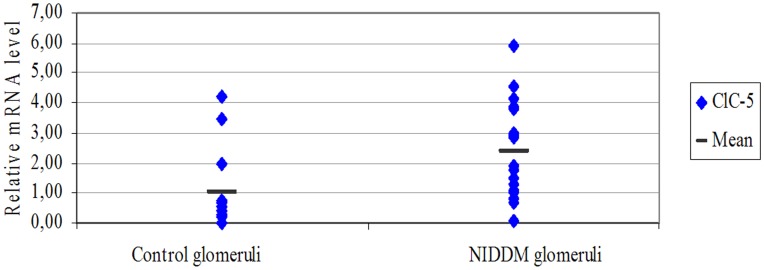
Real-Time quantification of ClC-5 in laser-microdissected biopsies of NIDDM and controls.mRNA level of ClC-5 in laser-microdissected glomeruli from NIDDM cases and controls. ClC-5 mRNA levels were significantly higher in NIDDM glomeruli than in control glomeruli (p<0.002). The relative expression levels of the gene of interest was obtained by dividing the gene’s expression level by the mean level of the different housekeeping genes. The relative levels of the controls were set to one.